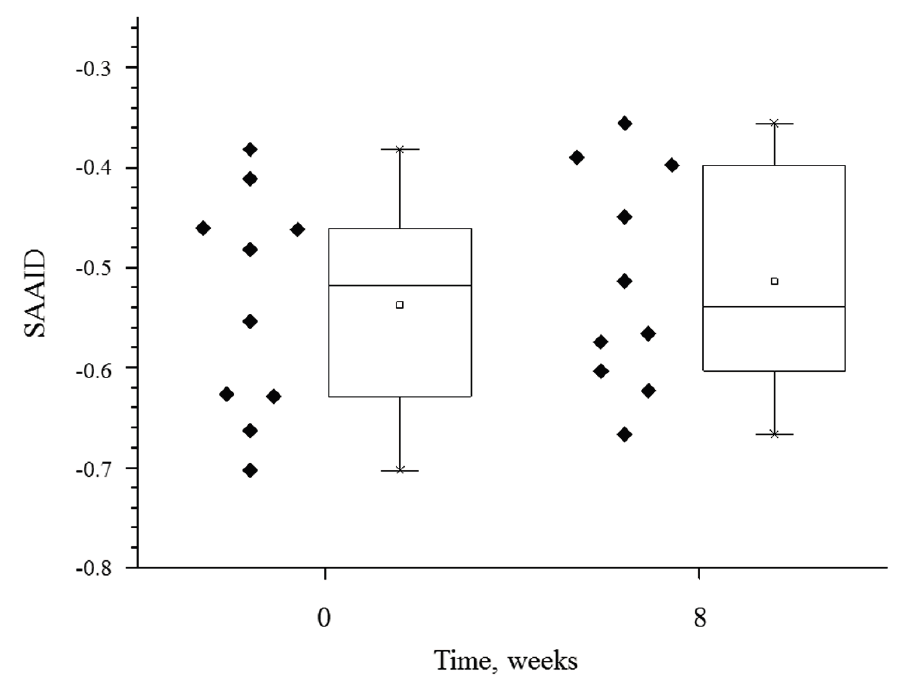
Figure 2. Boxplot of the SAAID (mean from the depth between 80 µm and 120 µm) prior to and subsequent to eight weeks of Spirulina platensis powder systemic application. The box represents the middle 50% of SAAID values including mean value and median. The “whiskers” above and below the box show the locations of the minimum and